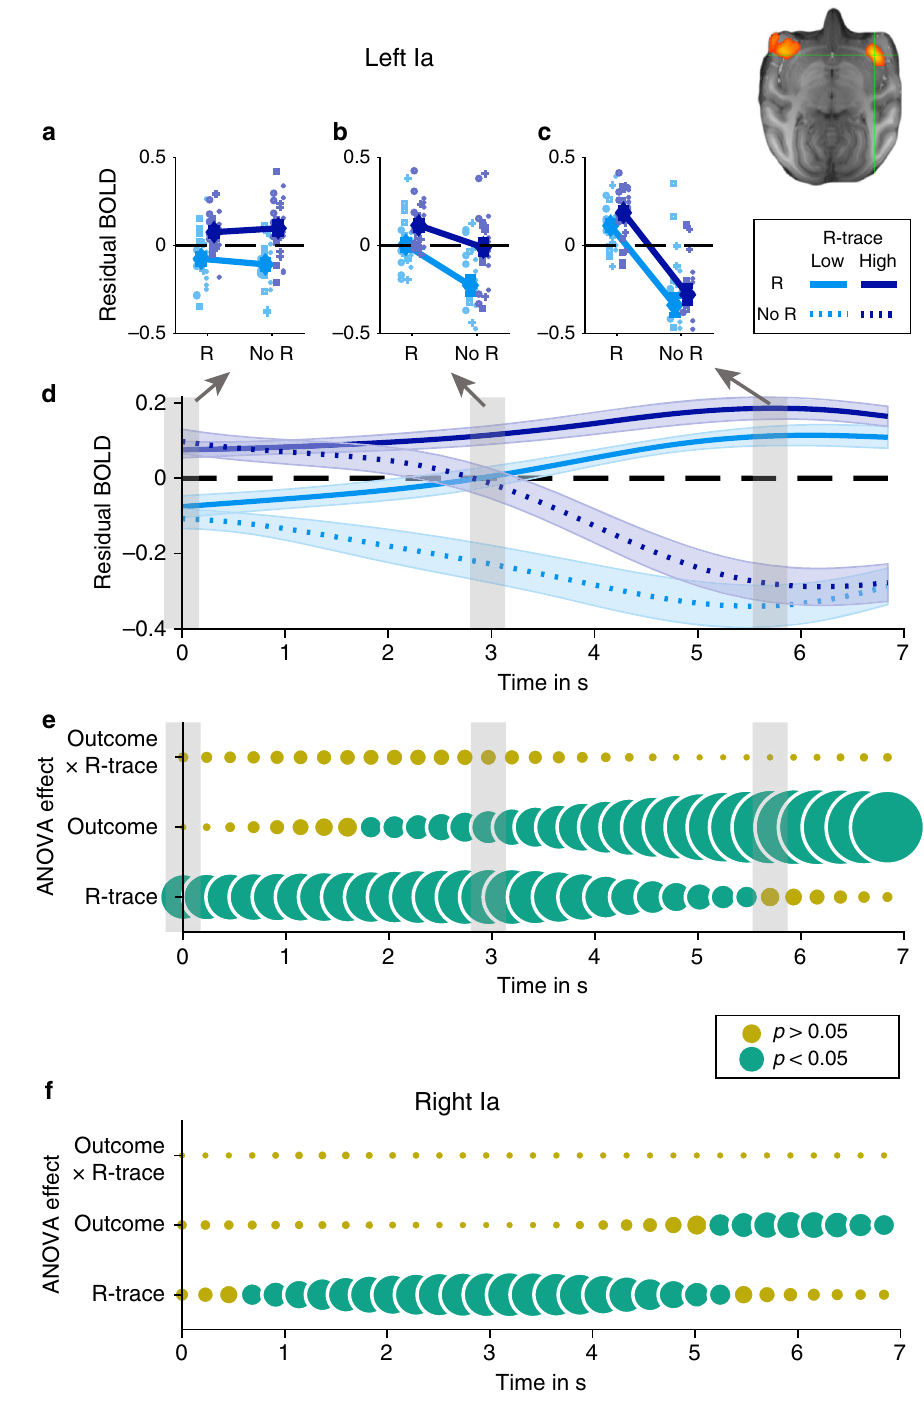
Fig. 7 Timecourse of bilateral Ia activity. a – c Residual BOLD effects in left Ia binned by R-trace (low/high; median split) and outcome (reward/no reward: R and no R) at three time points after feedback delivery (indicated as gray bars in panel d ; feedback occurs at time 0 s and the approximate peak of the macaque hemodynamic response function is 3 – 4 s later). d Time course of the four effects shown in panels a – c . Note that the BOLD signal clusters initially as a function of R-trace (low/high) and then regroups as a function of outcome (no reward/reward). Zero is time of feedback onset. e F -statistic for 2 × 2 (R-trace x outcome) ANOVA applied at each time step to the data shown in panel d . Rows indicate main effects and interaction effect. Circles are scaled F - values. Larger circles indicate higher F -values. Yellow indicate p -values of effects are bigger than 0.05. Green circles indicate effects for a given row and time point where p < 0.05. f Same analysis as in panel e applied to the right Ia replicate pattern of effects found in left Ia. Note that panels e , f (and subsequent analogous panels) are for illustration as this analysis does not control for autocorrelations in the BOLD signals and multiple comparisons. (Data are presented as mean values ±SEM across sessions; n = 25). Symbols indicate monkey identity in panels a – c